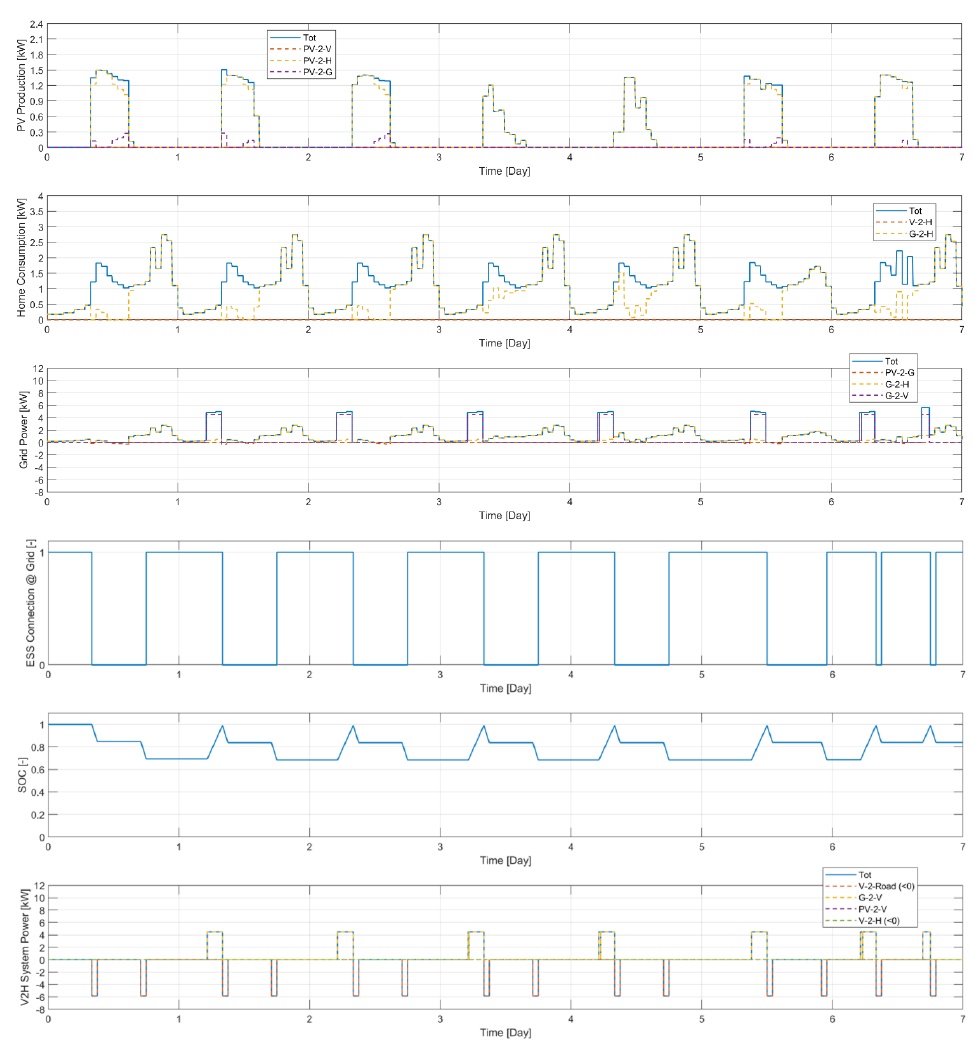
Figure 10. Summer week. Base Case results.